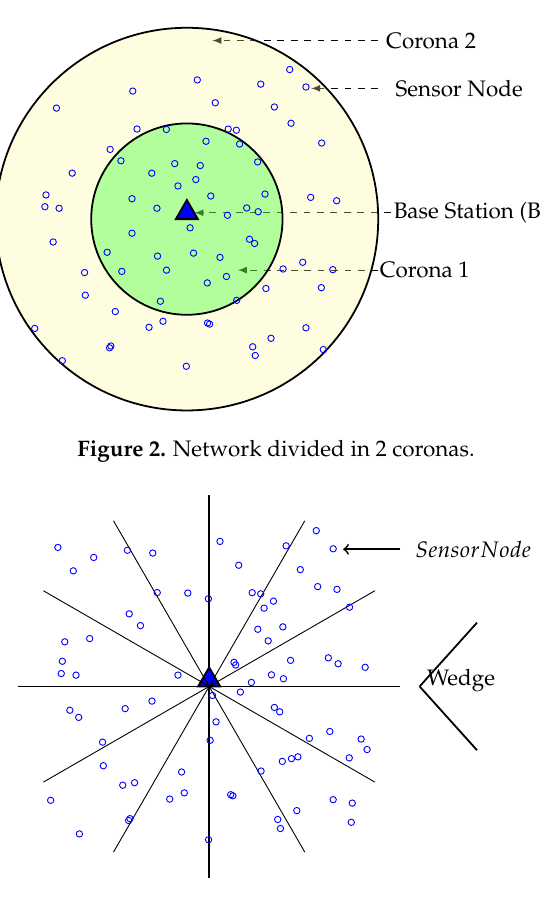
Figure 3. Network with 12 equiangular Wedges.